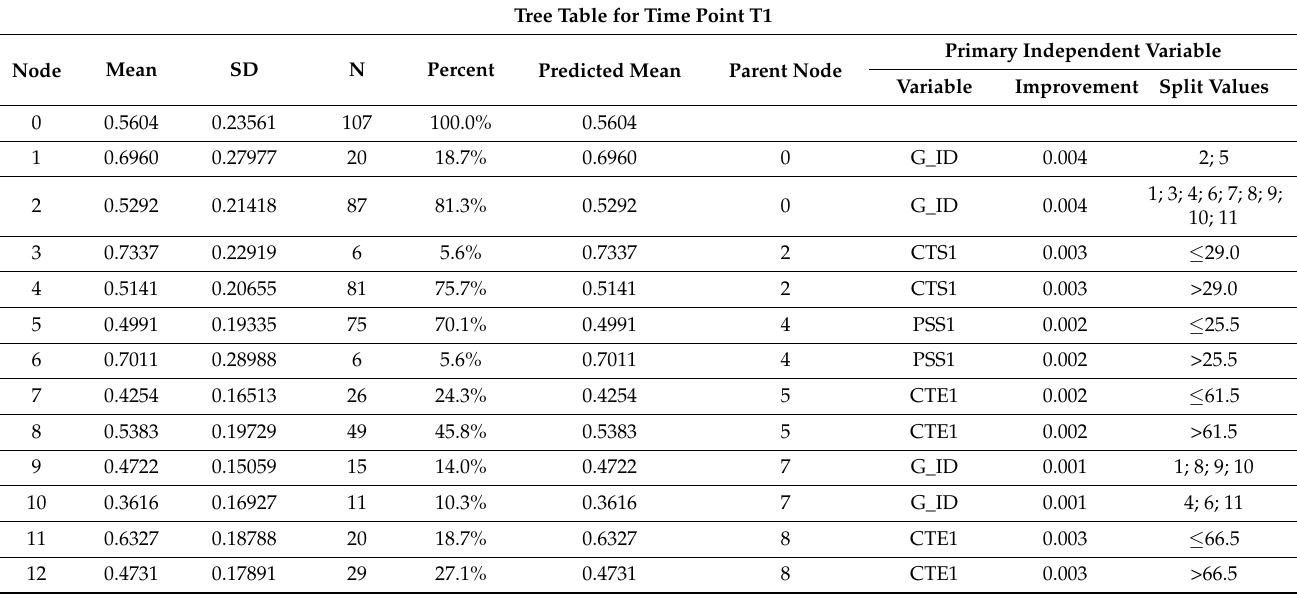
Table A3. Results description in table format for the designed C&RT Model 1. Tree Table for Time Point T1